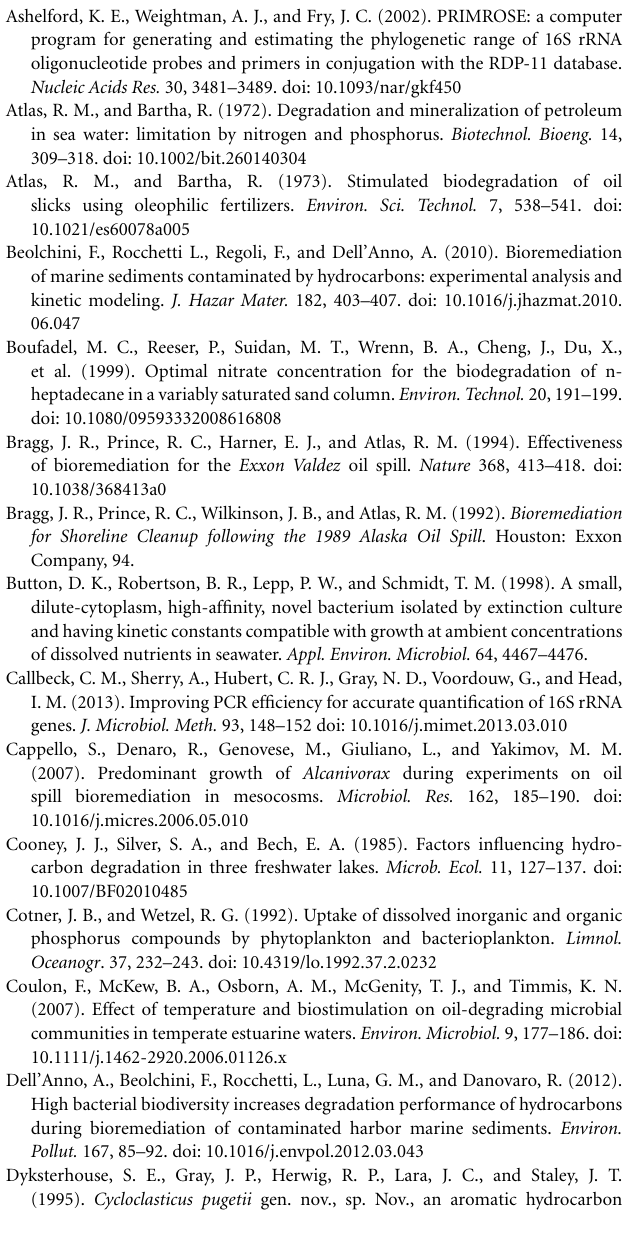
Figure S1 | Cumulative CO 2 production in beach sediment microcosms. phosphorus (black circles), inorganic nitrogen and phosphorus but no oil (gray circles) and killed control microcosms treated with formaldehyde phosphorus (white circles). Oil treated microcosms contained 10mg crude oil/g sediment and inorganic nutrient amendments equated to 5% N and 0.5% P by weight of the oil. Figure S2 | Effect of headspace flushing on physical removal of volatile saturated hydrocarbons from beach sediment microcosms. Concentrations of the individual compounds (C) after flushing the headspace with different volumes of air are presented relative to initial headspace concentration (C 0 ) of the volatile